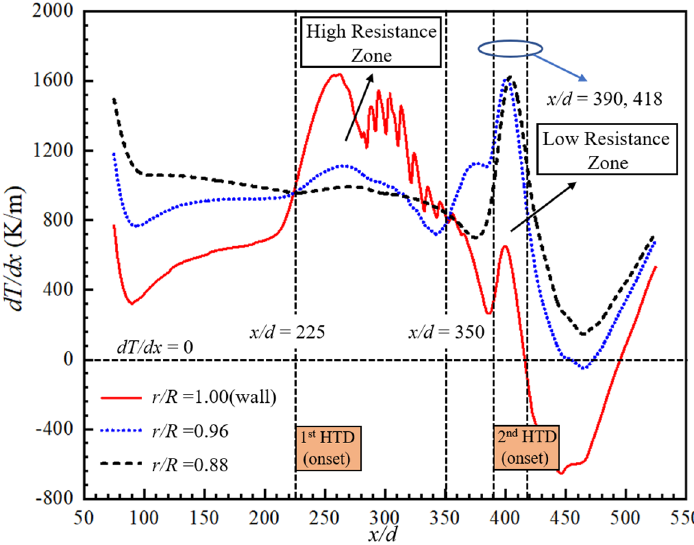
Figure 7. Comparison of temperature gradient along the flow direction.